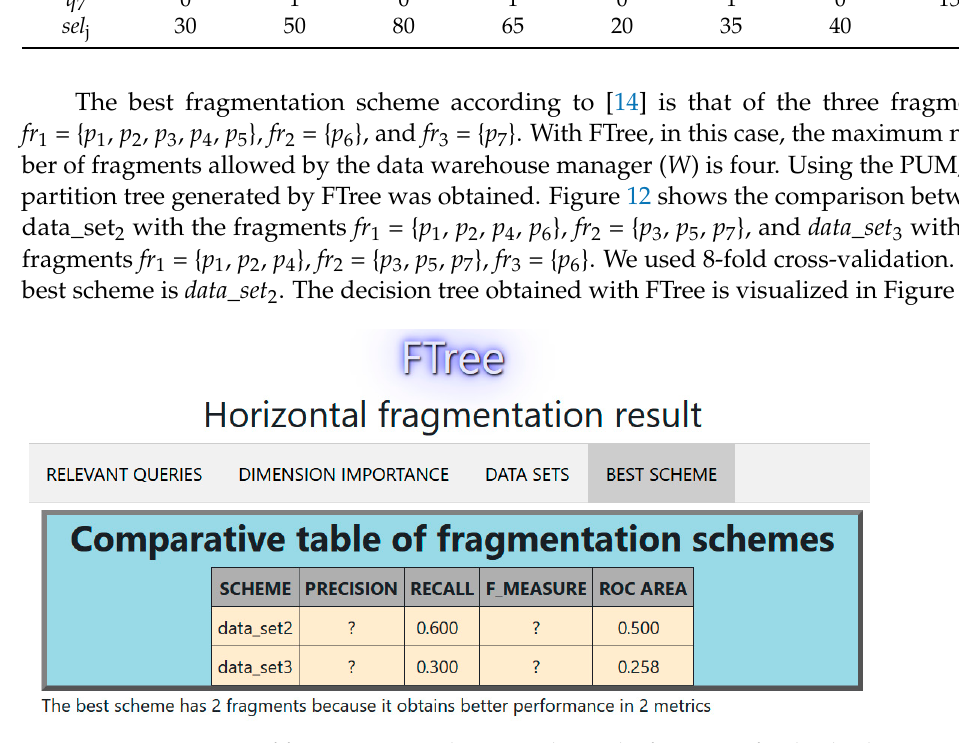
Figure 12. Comparison of fragmentation schemes with 2 and 3 fragments for the third experiment.